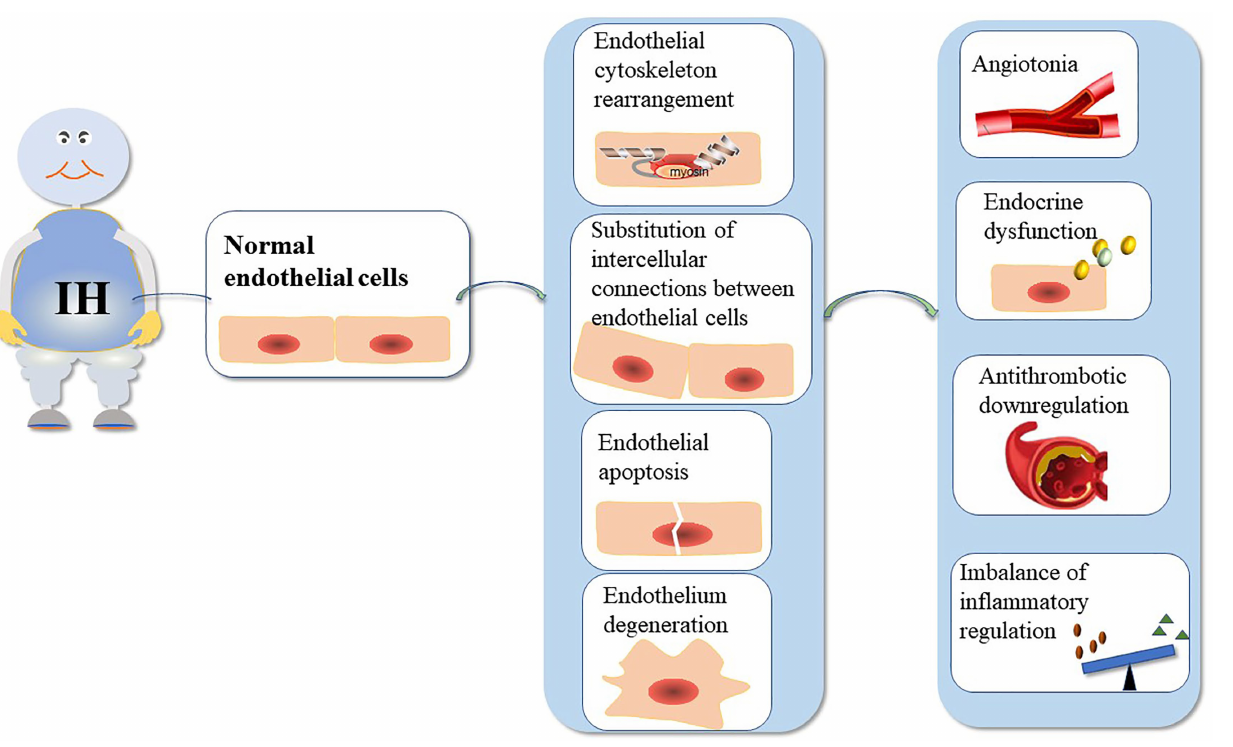
FIGURE 1 | The mechanism underlying VE injury caused by chronic IH. The duration and intensity of IH are positively correlated with ED. Chronic IH-induced sympathetic nerve excitation, inflammation, and oxidative stress can lead to ED. IH can cause endothelial barrier dysfunction and endothelial cell dysfunction. ED is dependent on the integrity of the endothelial